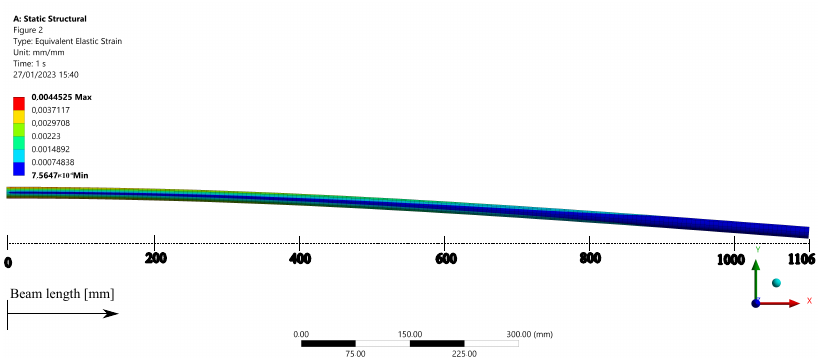
Figure 5. FEM simulation results of equivalent elastic strain on the static tests for a 50 N load applied at the free end of the beam (position at 1106 mm).